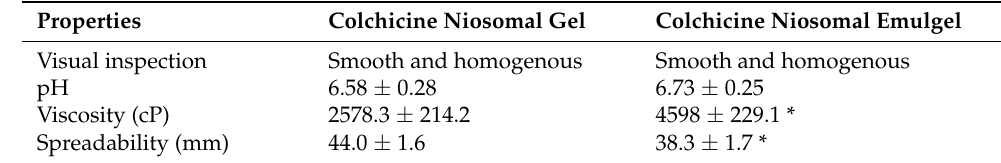
Table 4. Characterization of optimized colchicine niosomal gel and emulgel:.